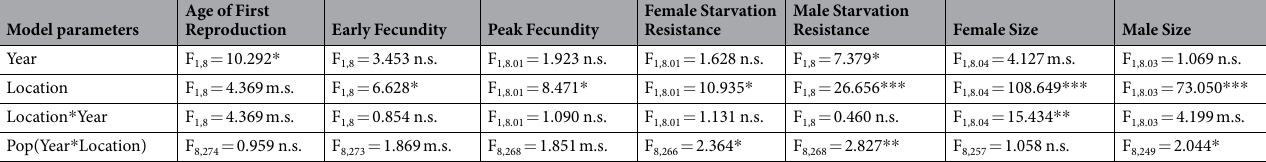
Table 1. Analyses of differences in early differentiation (ANOVA) in phenotypic traits. Note: significance levels: